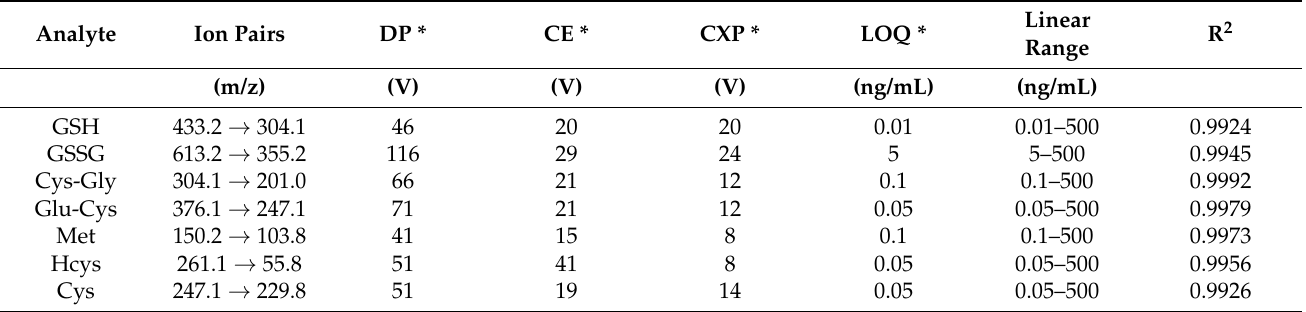
Table 1. HPLC-MS/MS method parameters and